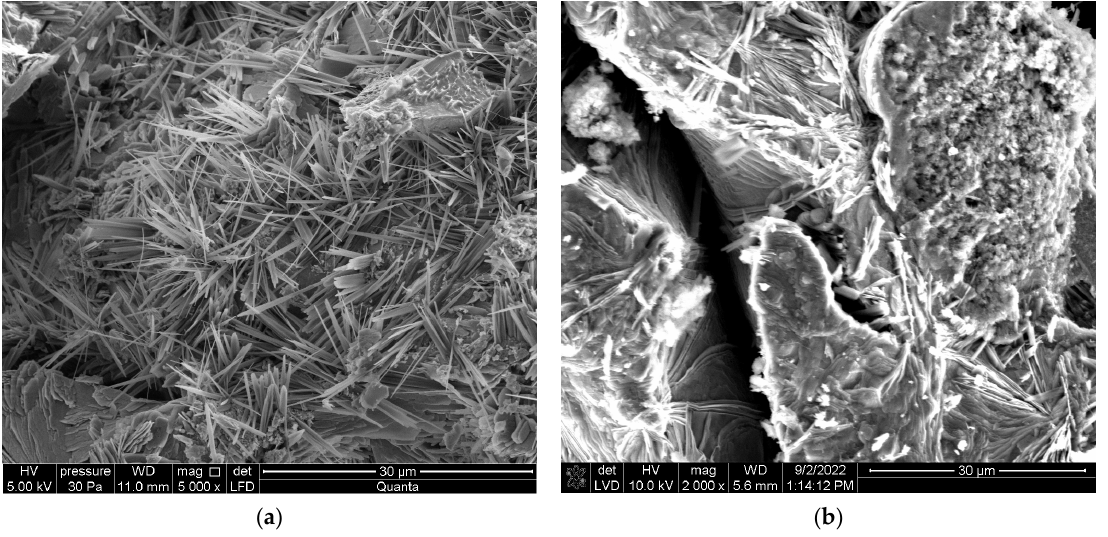
Figure 22. Microstructure of brick modified by GS (50%) and QS (50%); ( a ) microstructure of the material after 6 years (in 2022) from the laboratory production (in 2016), 30 μ m magnification; ( b ) microstructure of the material after 6 years from the production, 30 μ m magnification.